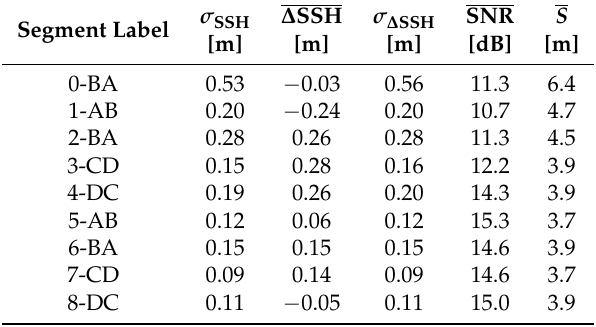
Table 4. Altimetric results for GPS PRN03 with an integration time of 10 ms (coherent) and 10 s (incoherent).